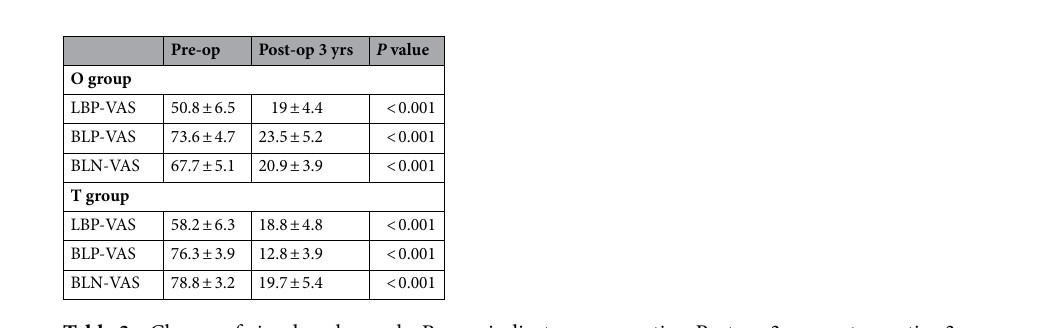
Table 3. Change of visual analog scale. Pre-op indicates preoperative; Post-op 3yrs, postoperative 3 years.